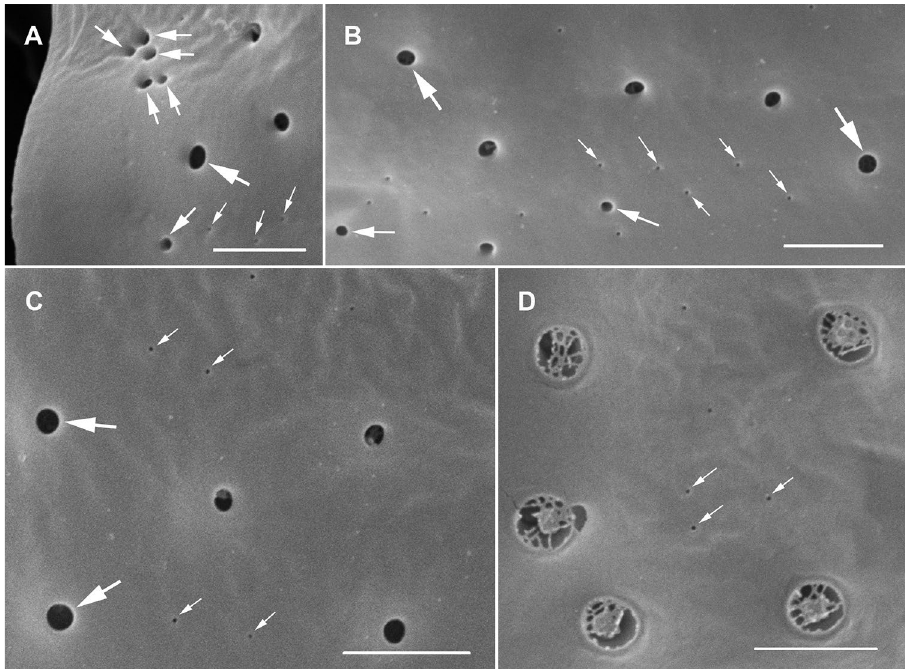
Figure 8. Scanning electron micrographs of Ostreopsis lenticularis strain C202 showing the thecal pores. ( A–C ) Outside views showing large (large arrows), medium sized (medium arrows in A and B) and small (small arrows) pores. Note the group of medium pores close to the plate margin in A. ( D ) Inside view, recognize the inner covering perforated by irregular openings of large pores and uncovered small pores (small arrows). Scale bars = 2